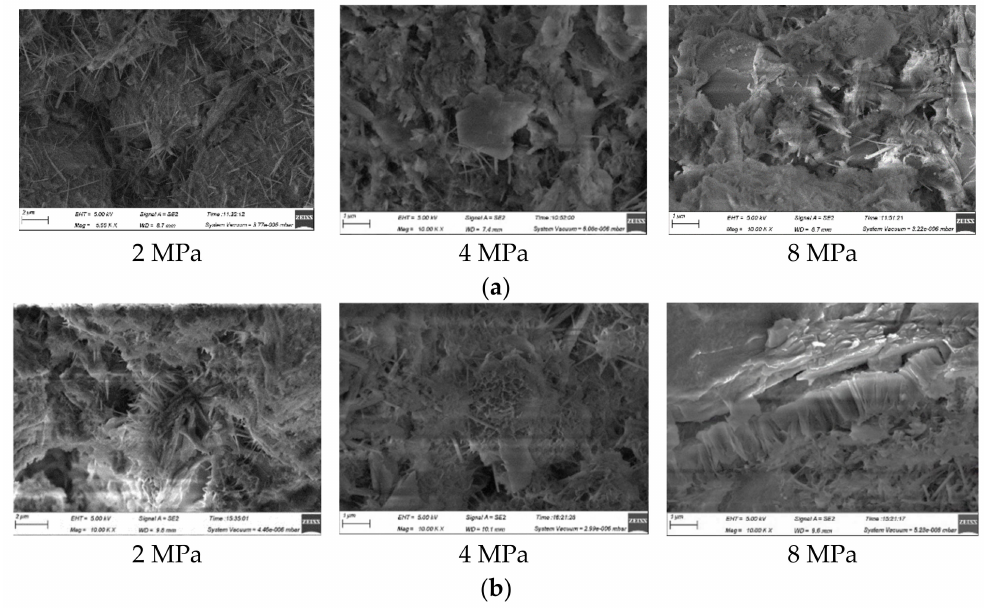
Figure 9. Microstructures of grout slurry under different curing pressures: ( a ) clay-cement grout slurry; ( b ) stone powder-cement grout slurry.